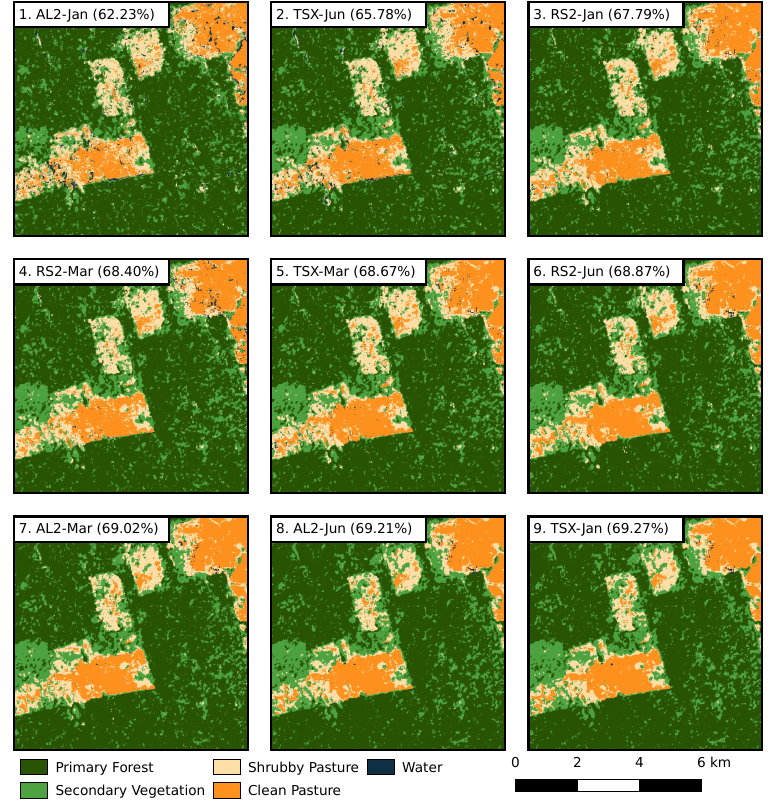
Figure 4. Subsets of the classification result, achieved after each iteration of the wrapper. The classification is based on all specified data sets, e.g., the RS2-Jan is selected as the third data set and added to the AL2-Jan and TSX-Jun, which have been selected beforehand. The classification of these three datasets results in an accuracy of